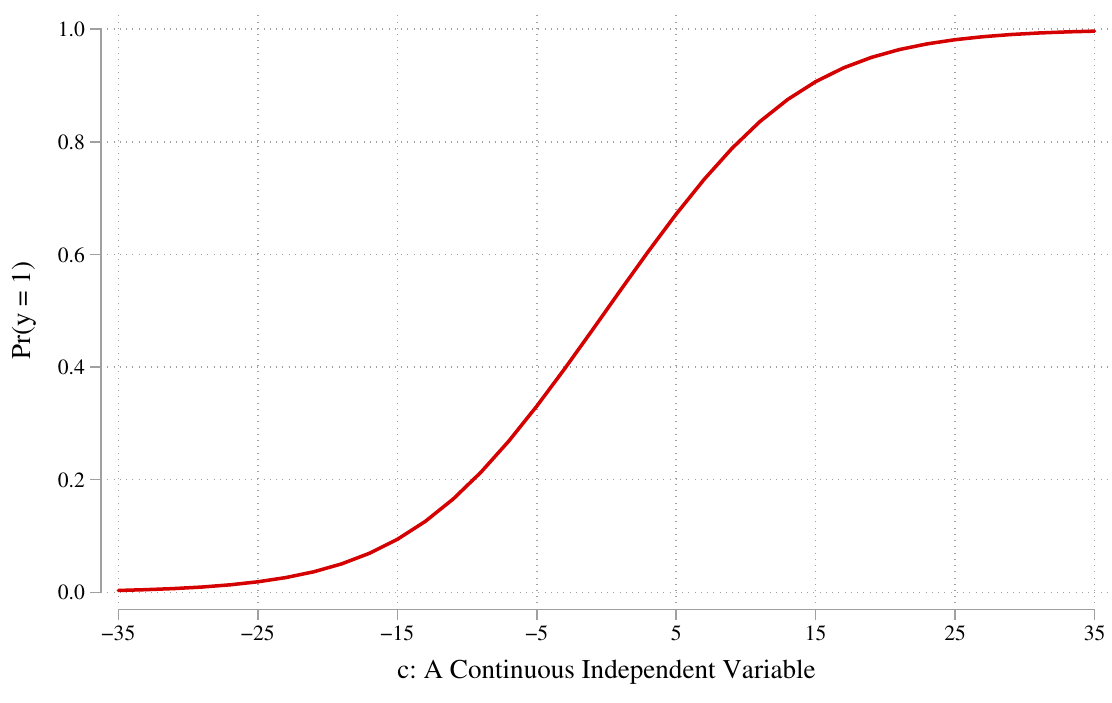
Figure 3: Simulated data: predicted probability of y = 1 across the range of c (a continuous